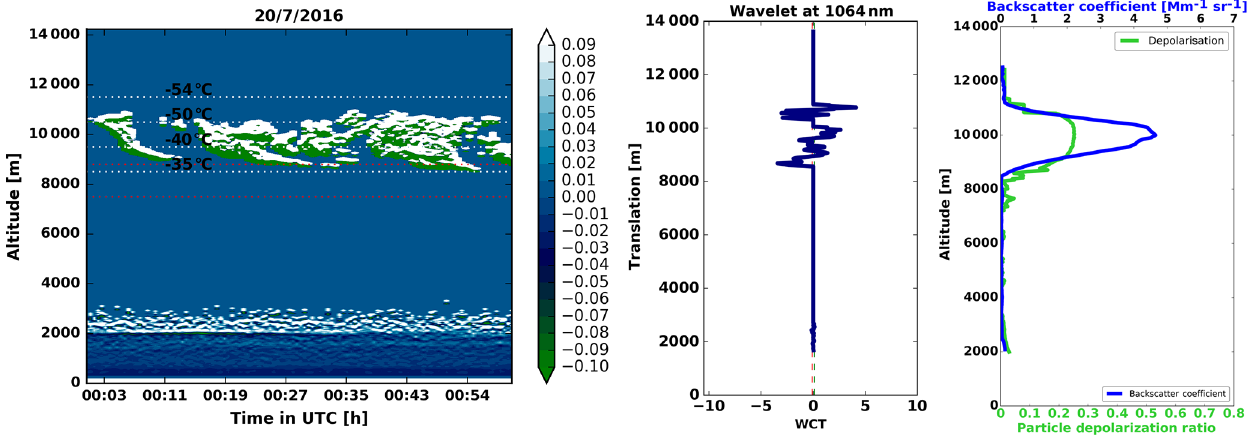
Figure 3. Cirrus cloud hourly evolution as determined from Polly XT with temperatures values marked with white lines and the temperature criteria marked with red lines (a) , the averaged WCT applied to 1064nm (b) , and the mean particle depolarisation ratio (green) and the backscatter coefficient profile (blue) at 532nm (c) on 20 July 2016 at Kuopio station.